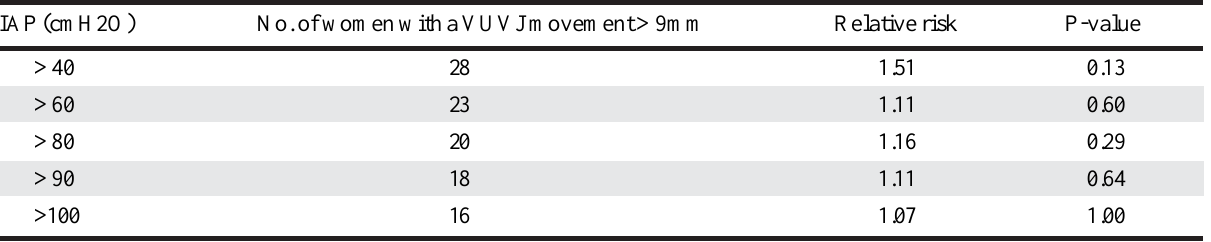
TABLE 2 - The impact of IAP on women with SUI presenting UVJ hypermobility (a vertical UVJ movement over 9 mm) as assessed by perineal ultrasound with a barely empty bladder.